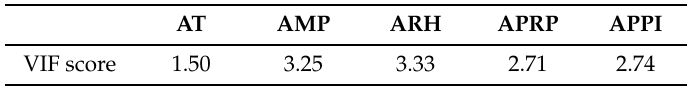
Table 2. VIF scores of the variables.